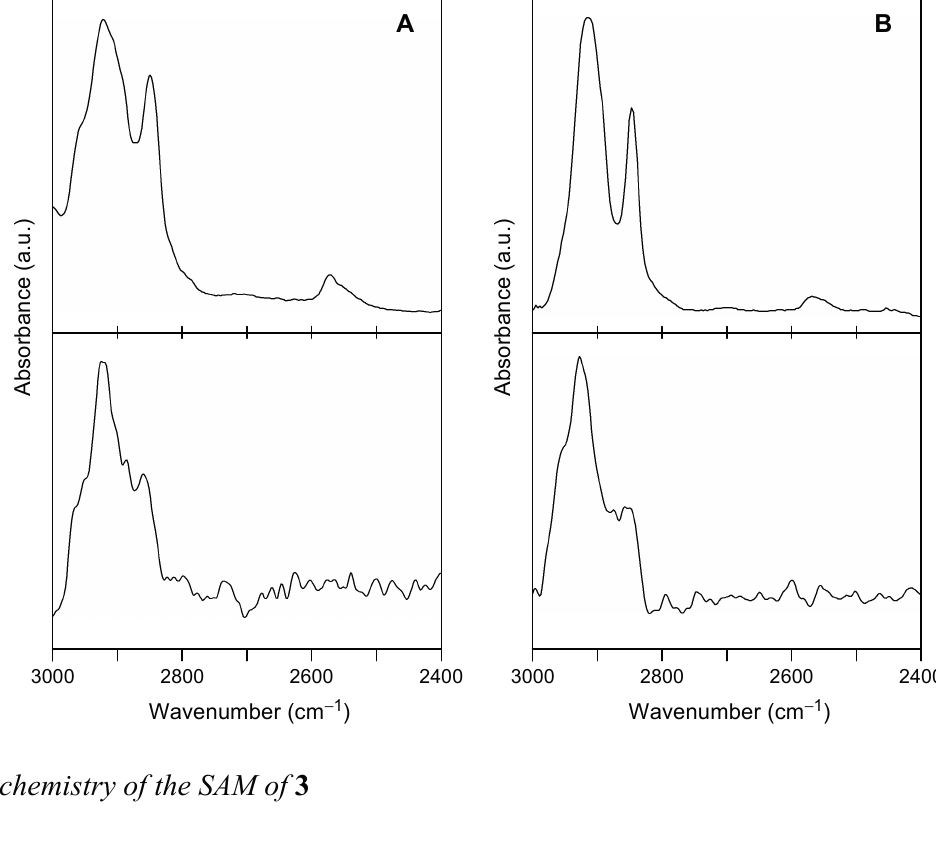
Figure 3. Infrared absorption spectra of trithiols 3a ( A ) and 3b ( B ): upper spectra, transmission spectra for drop-cast films prepared on a KBr plate using CHCl 3 solutions; lower spectra, polarization modulation-infrared reflection absorption spectroscopy (PM-IRRAS) spectra for the thiolate SAMs on